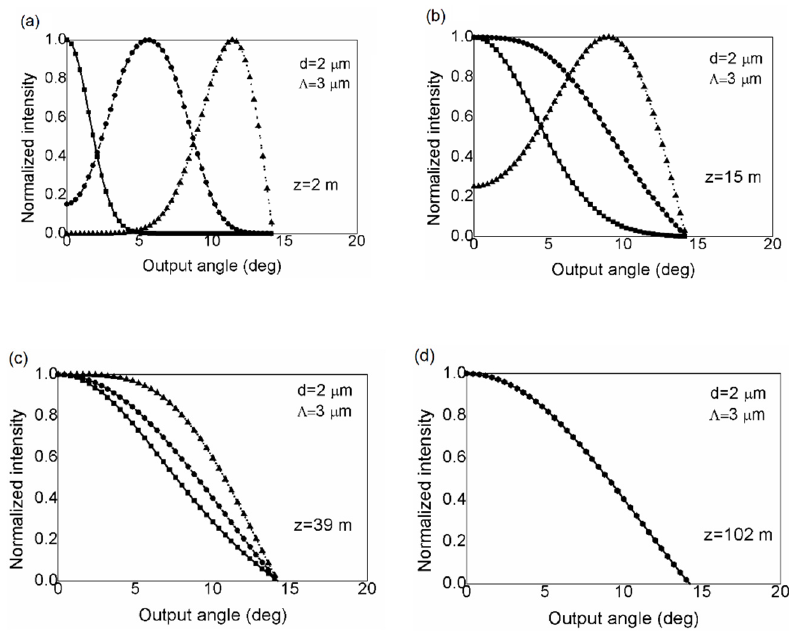
Figure 3. Normalized output angular power distribution calculated by solving the Langevin equation for launch angles 𝜃 (cid:2868) = 0°( ∎ ), 5°(•), and 10°( ▲ ) and normalized output angular power distri- bution calculated by solving the power flow equation [19] for launch angles 𝜃 (cid:2868) = 0°( ), 5°(- - -), and 10° ( • • • ), for fiber length ( a ) z = 2 m; ( b ) z = 15 m; ( c ) 𝑧 ≡ 𝐿 (cid:3030) = 39 m ; ( d ) 𝑧 ≡ 𝑧 (cid:3046) = 102 m ( 𝛬 = 3 µ m and d = 2